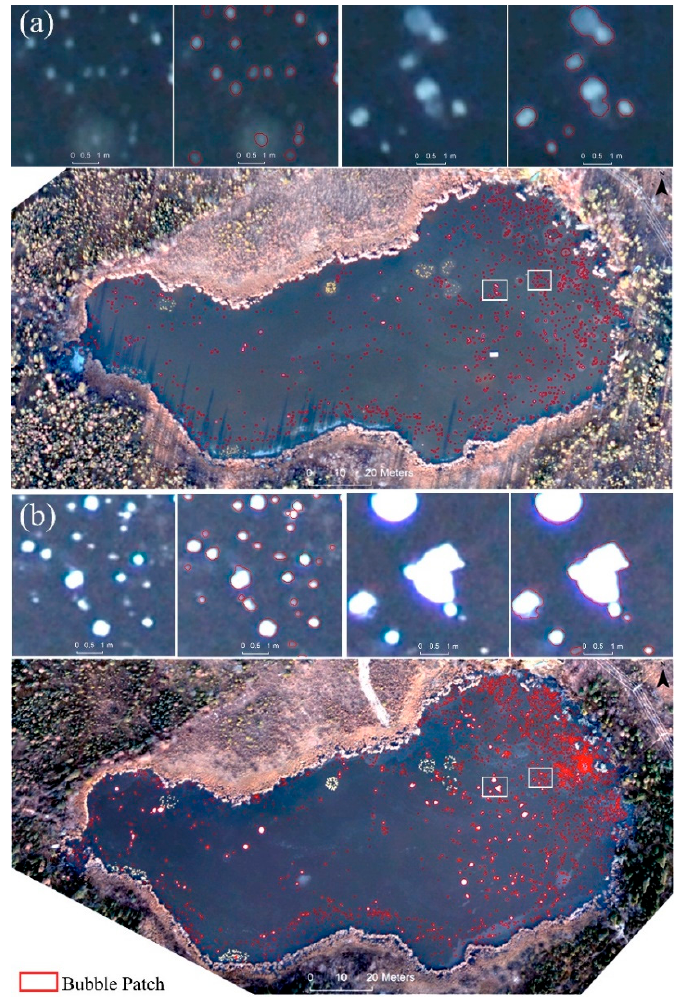
Figure 7. Bubble patch map of Goldstream Lake (64.91° N, 147.84° W), Fairbanks overlaid on true color composite of aerial image acquired on ( a ) 14 October 2012 and ( b ) 13 October 2012. The areas outlined in white boxes are zoomed on the top of respective images.